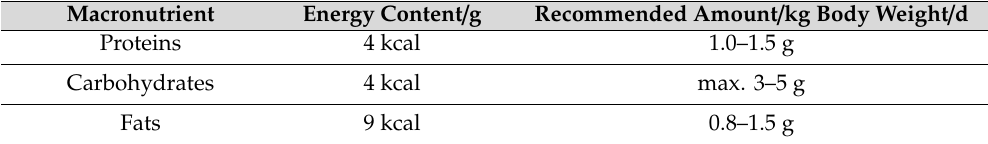
Table 7. Macronutrient requirements for